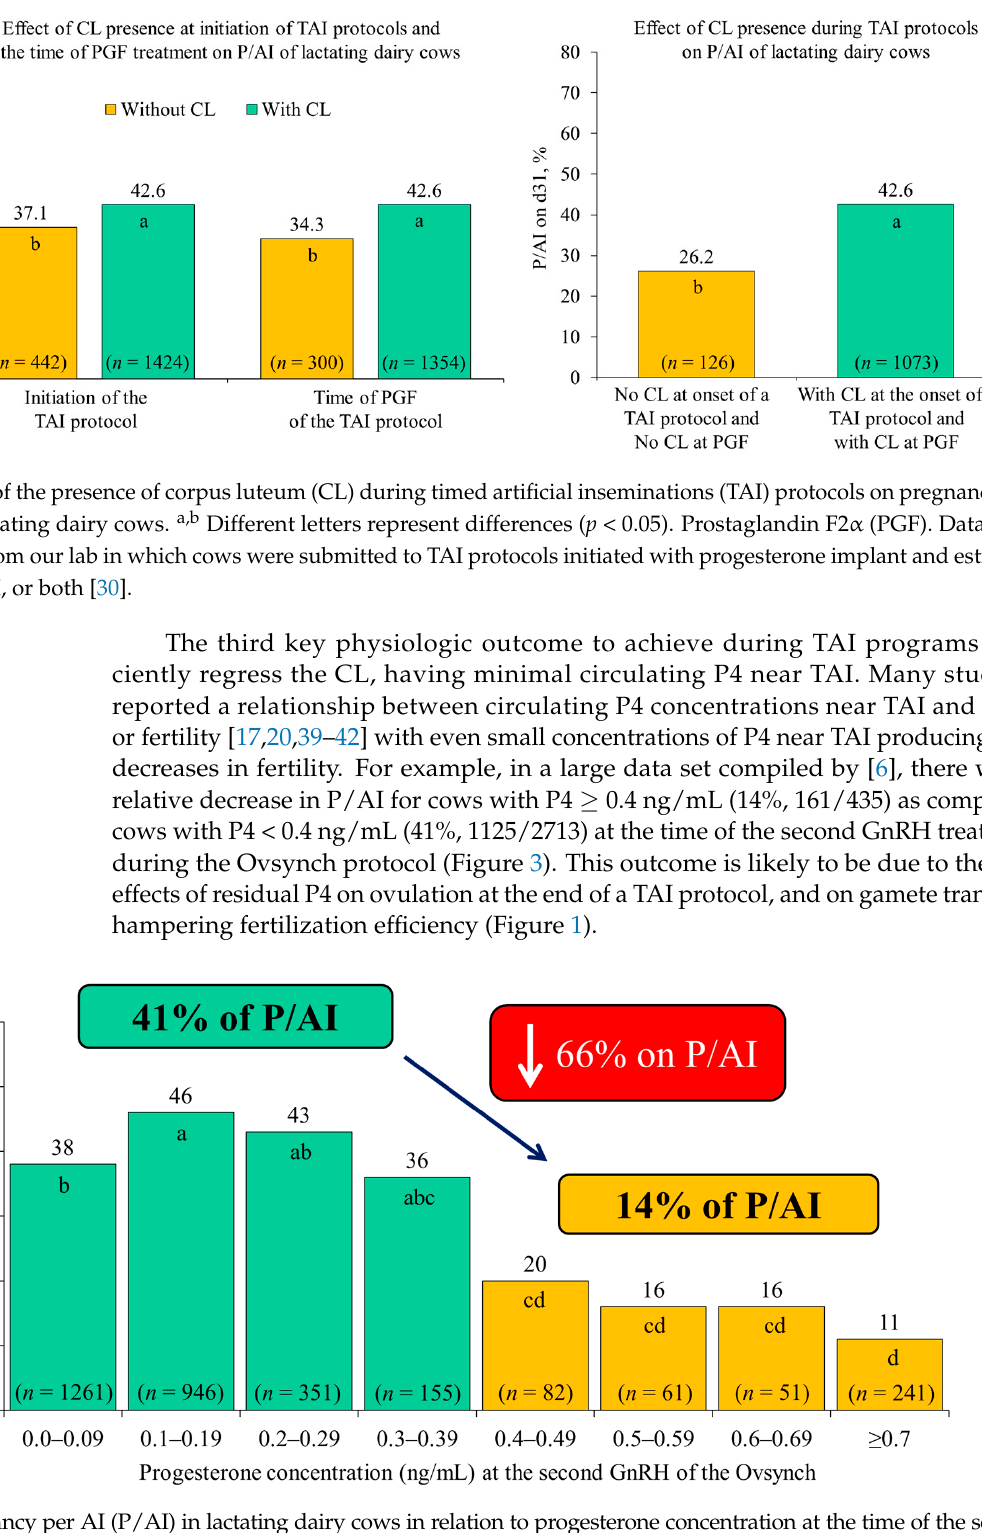
Figure 2. Effect of the presence of corpus luteum (CL) during timed artificial inseminations (TAI) protocols on pregnancy per AI (P/AI) of lactating dairy cows. a,b Different letters represent differ- ences ( p < 0.05). Prostaglandin F2 α (PGF). Data from 3 experiments from our lab in which cows